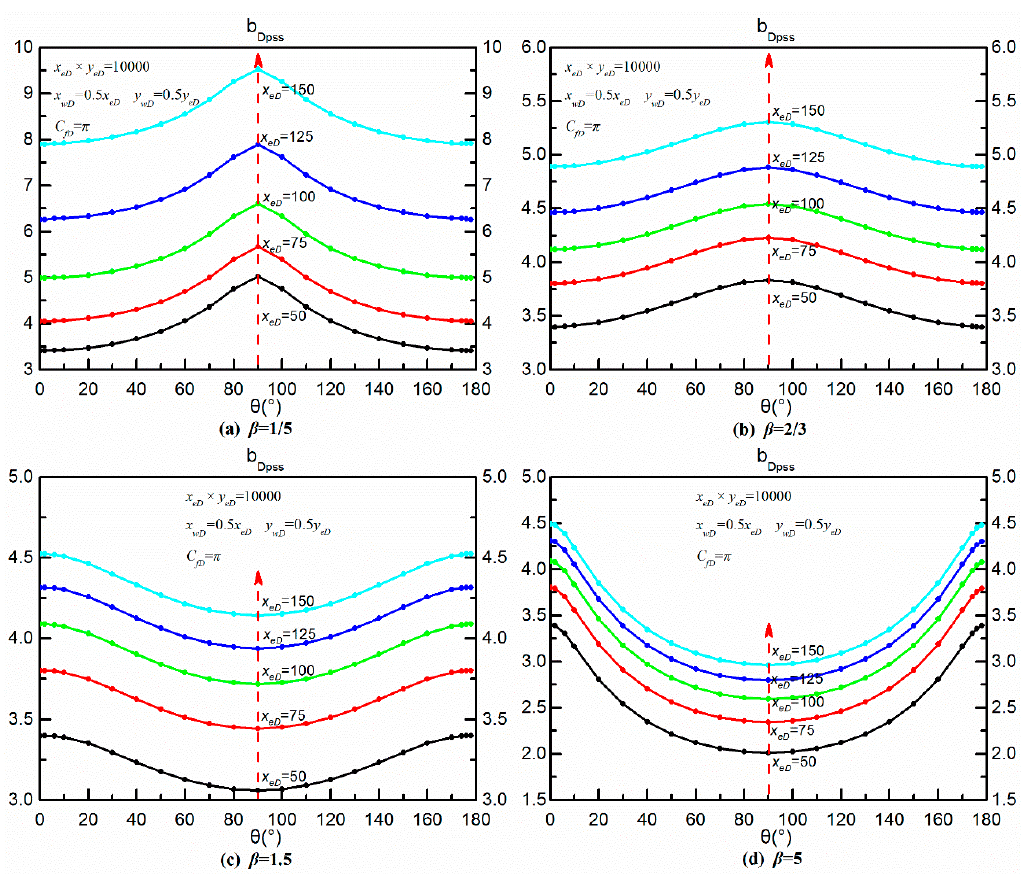
Figure 9. Effect of reservoir shape on pseudo-steady-state constant: ( a ) β = 1/5; ( b ) β = 2/3; ( c ) β = 1.5; ( d ) β = 5